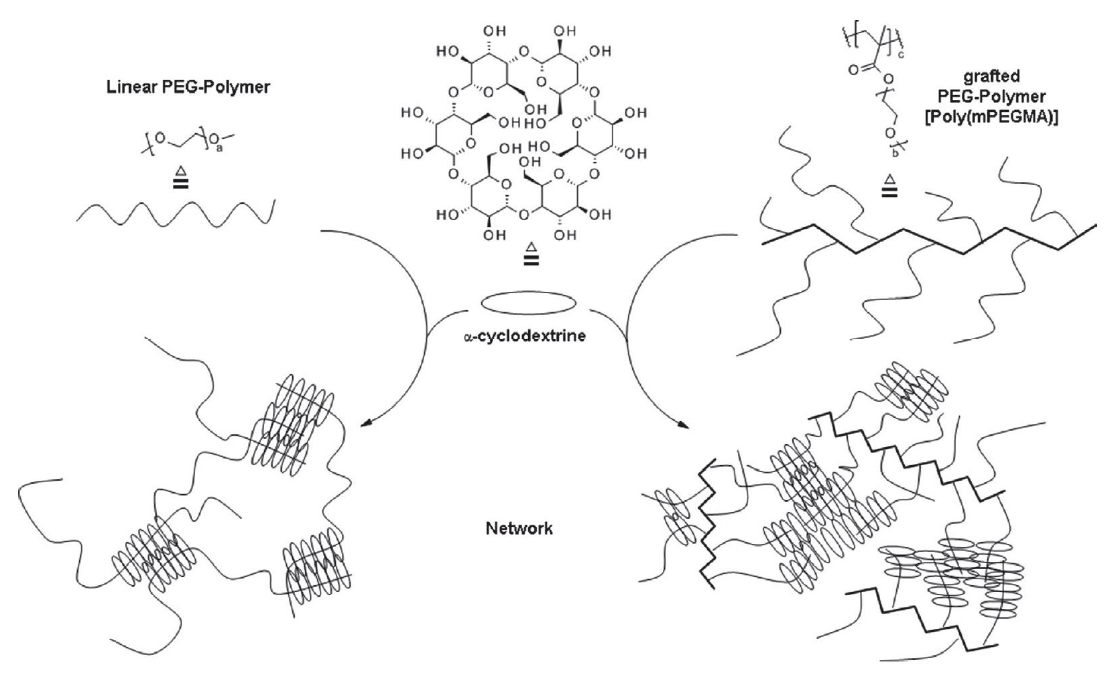
Figure 6. Schematic structure of PPR hydrogels made from linear (left) and PEG-grafted copolymer (right) with α -cyclodextrin. Adapted with permission from Macromol. Chem. Phys . 2019 , 220 , 1900081